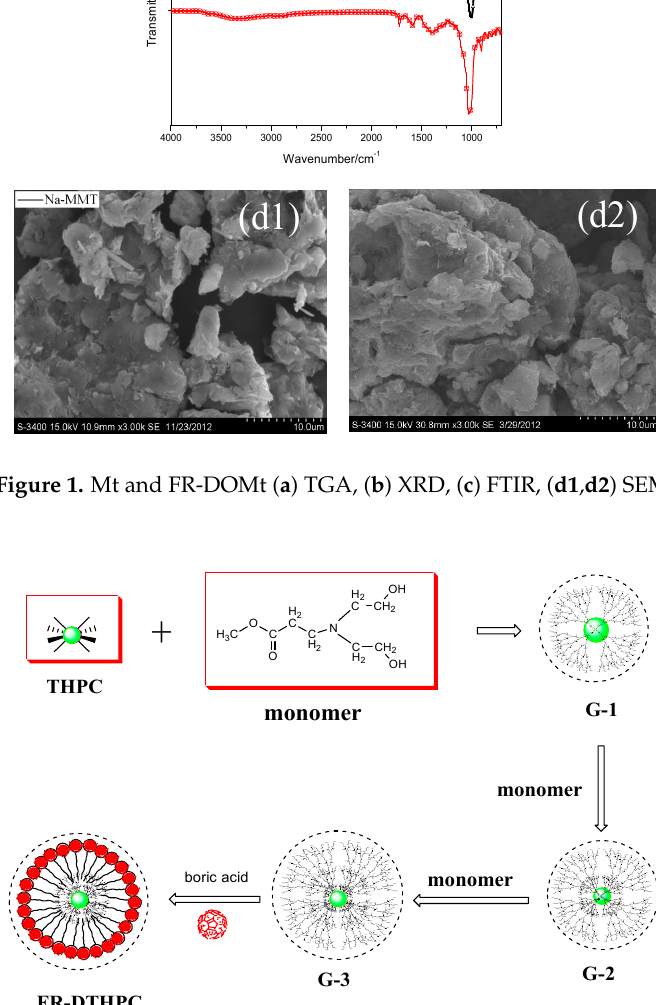
Scheme 2. Preparation process of FR-DTHPC.